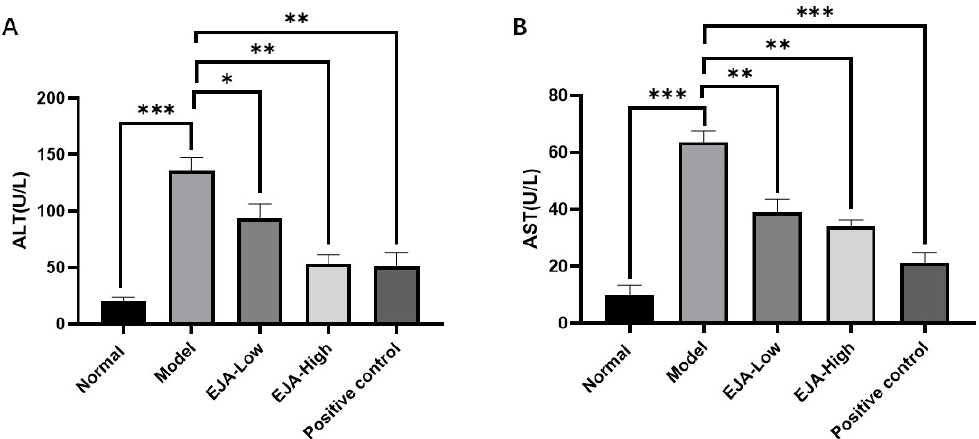
Figure 1. A. japonica treatment attenuated Con A-induced acute liver injury. ( A ) Effect of EJA on serum ALT levels; ( B ) Effect of EJA on serum AST levels. (ns = nonsignificant, * p < 0.05, ** p < 0.01, and *** p < 0.001 among the compared groups. Student t -test was performed. EJA: A. japonica extract).